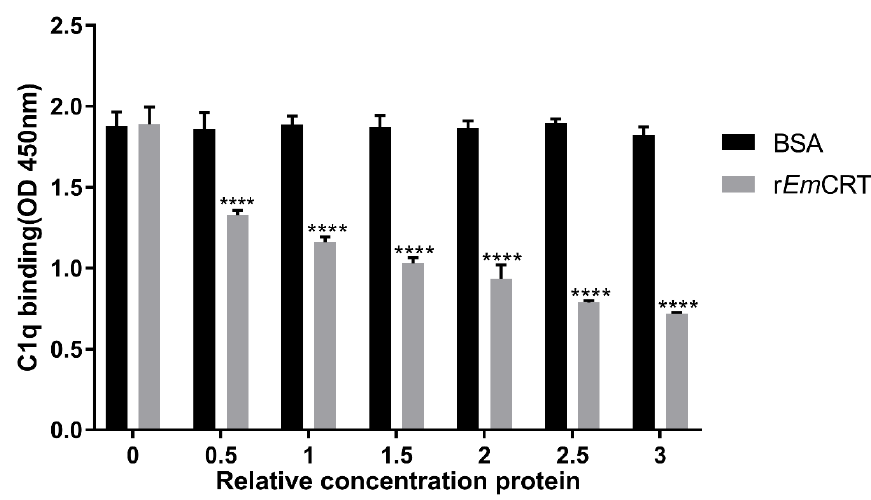
Figure 5. r Em CRT inhibited human C1q to bind to IgM. Total 10 µ g/mL of C1q was pre-incubated with 0.5 to 3 times excess ( w : w ) of r Em CRT or BSA and then transferred to the plates coated with IgM. After being washed, anti-C1q polyclonal antibody was used to detect C1q binding to IgM in presence of r Em CRT. Data are expressed as mean ± SDs from three independent experiments and statistical analysis was performed using one-way ANOVA. **** p < 0.0001 compared to BSA control.